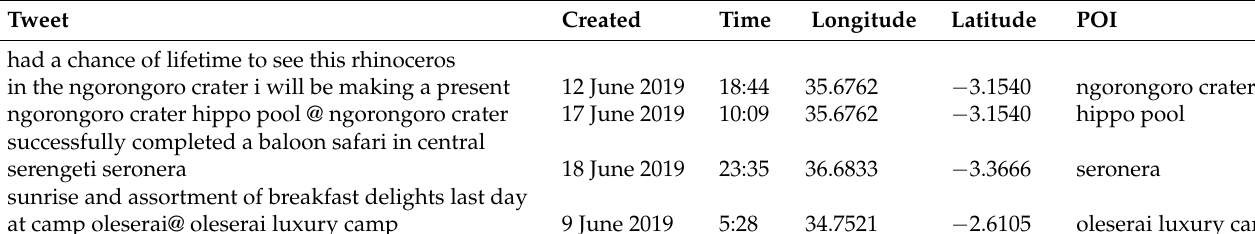
Table 12. Examples of tweets with newly found POI.